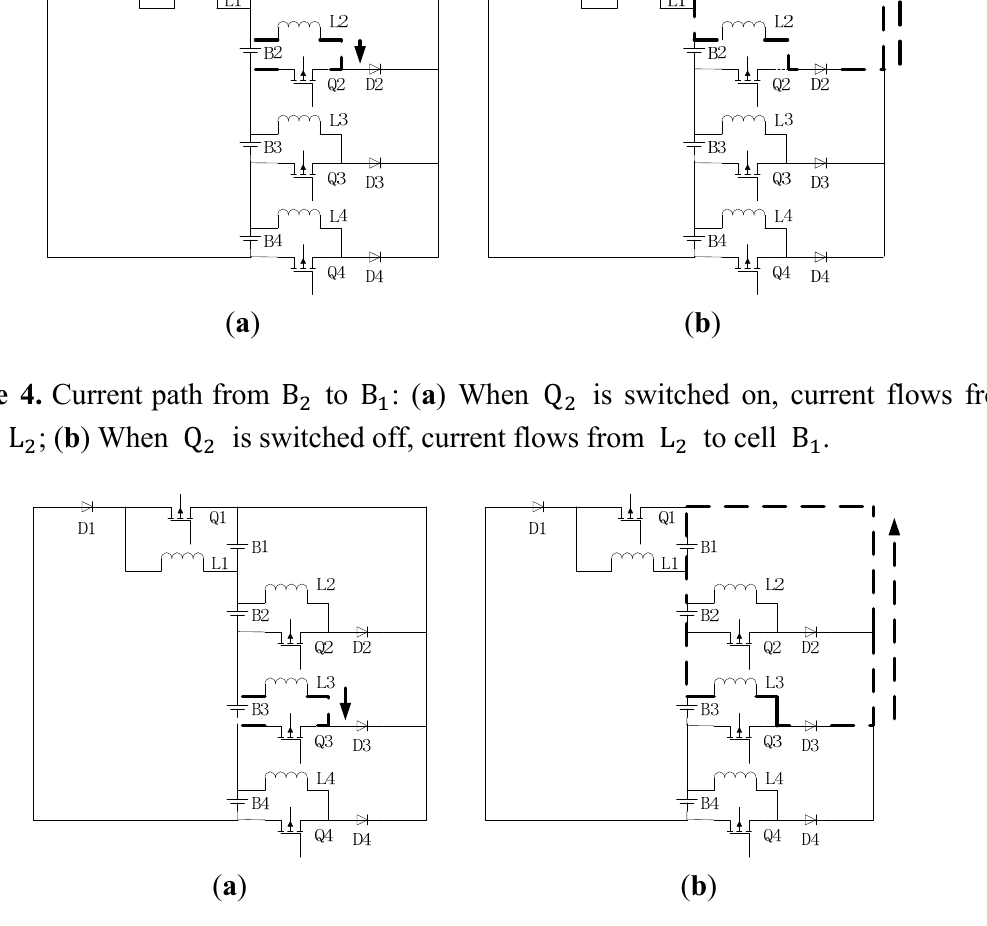
Figure 5. Current path from B to L ; ( b ) When Q from B (cid:2871) (cid:2871)